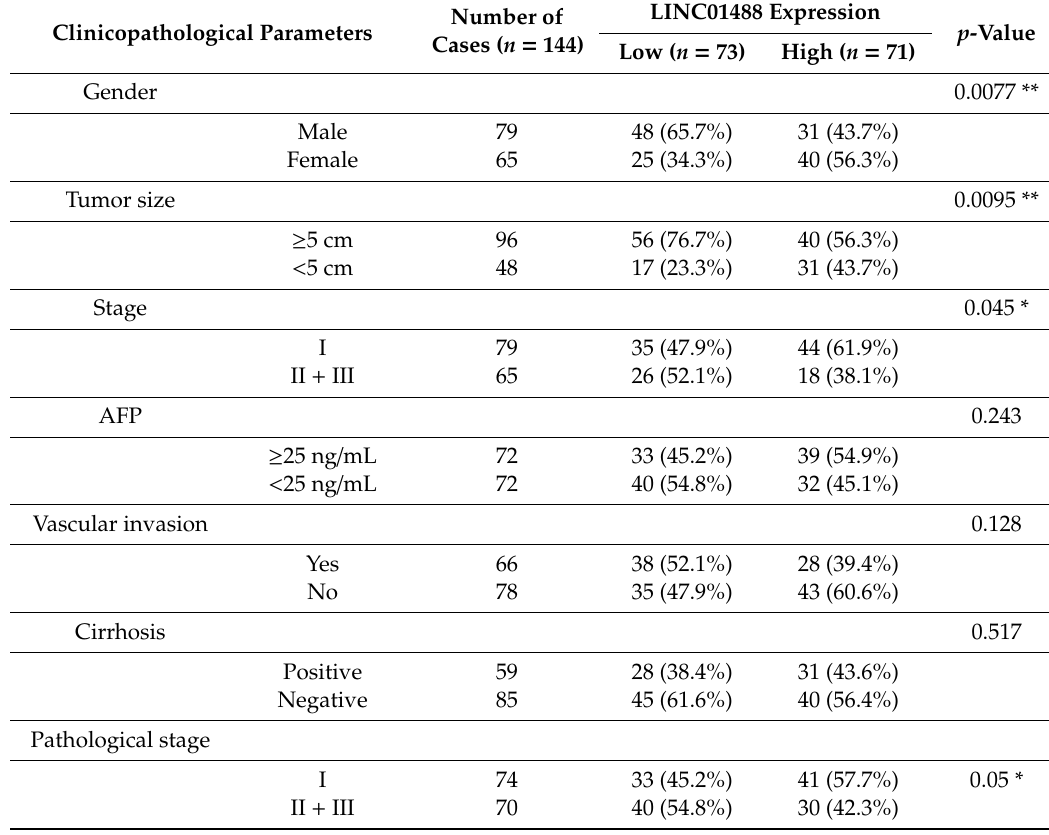
Table 1. Characterization of LINC01488 expression in HCC patients determined by